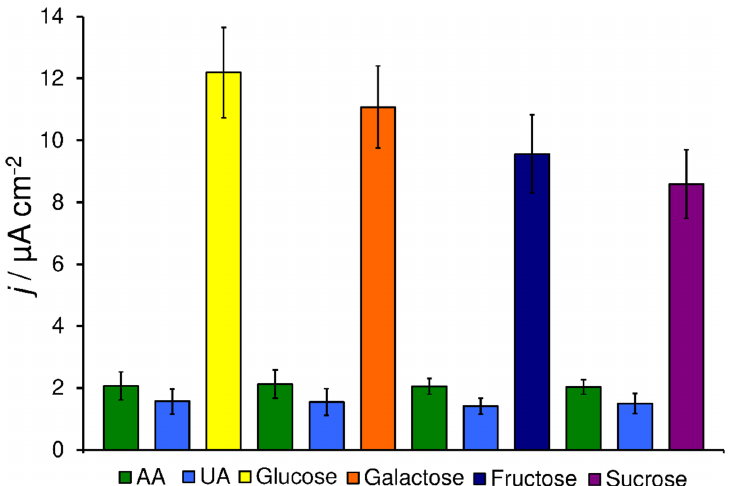
Figure 4. Repetitive sequential analyses of 6 × 10 − 6 mol L − 1 AA and UA and 6 × 10 − 5 mol L − 1 saccharides at one pCuFE. Hydrodynamic amperometry in 0.1 mol L − 1 NaOH at E d = +0.6 V vs. Ag/AgCl, errors bars show standard deviation of the measurement ( n = 8).